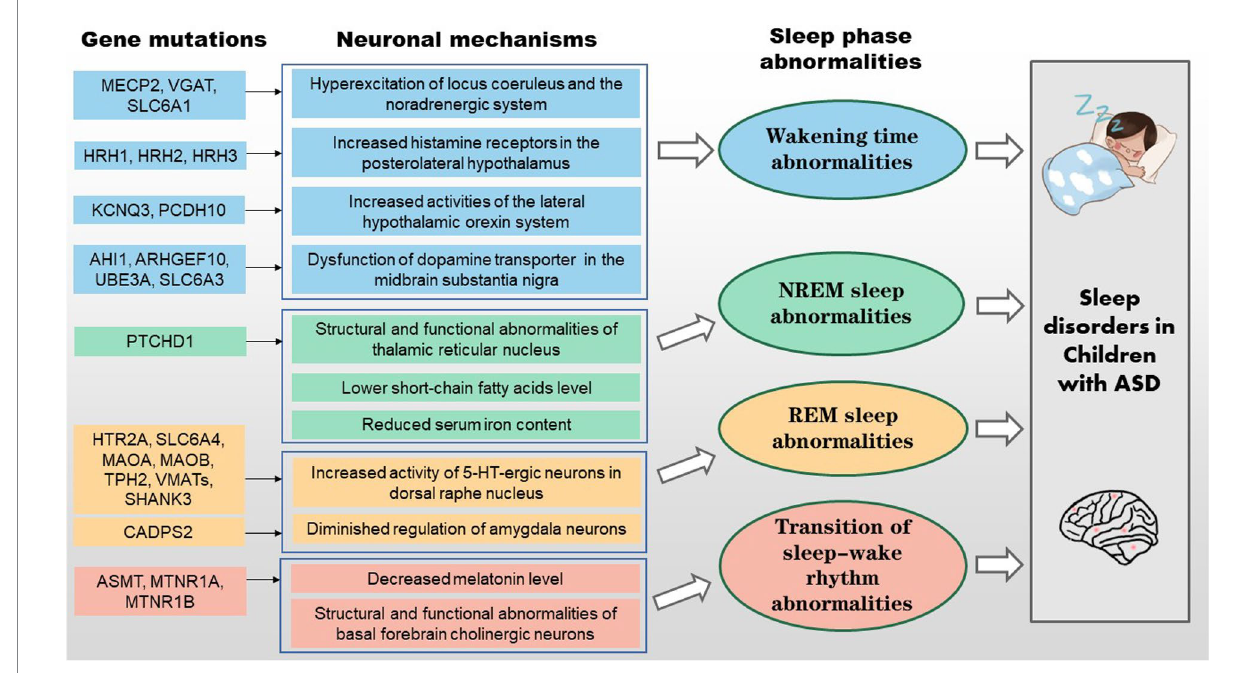
FIGURE 2 Schematic representation of the genetic and neural mechanisms of sleep disorders in children with